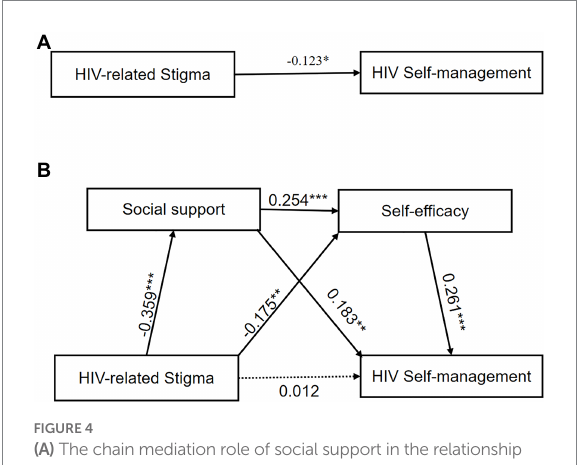
FIGURE 4 (A) The chain mediation role of social support in the relationship between HIV-related stigma and HIV self-management. (B) The solid line and dashed line indicated significant and non-significant path coefficients, respectively. * p < 0.05, ** p < 0.01, *** p <